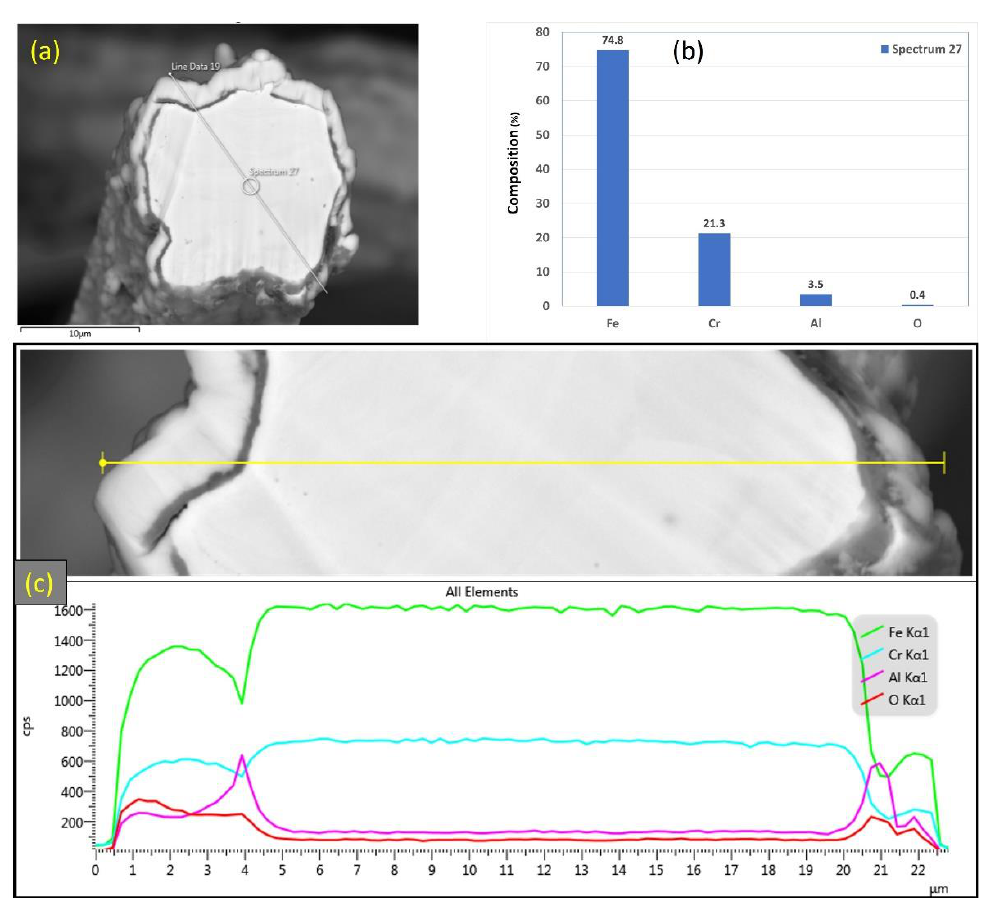
Figure 7. ( a ) SEM micrograph of a cross section of the 12 μm FeCrAl fiber after one MSHT cycle, ( b ) EDS scan at the center of the fiber, ( c ) the characteristic X-ray counts along the specified line scan (Line Data 19) marked in ( a ).